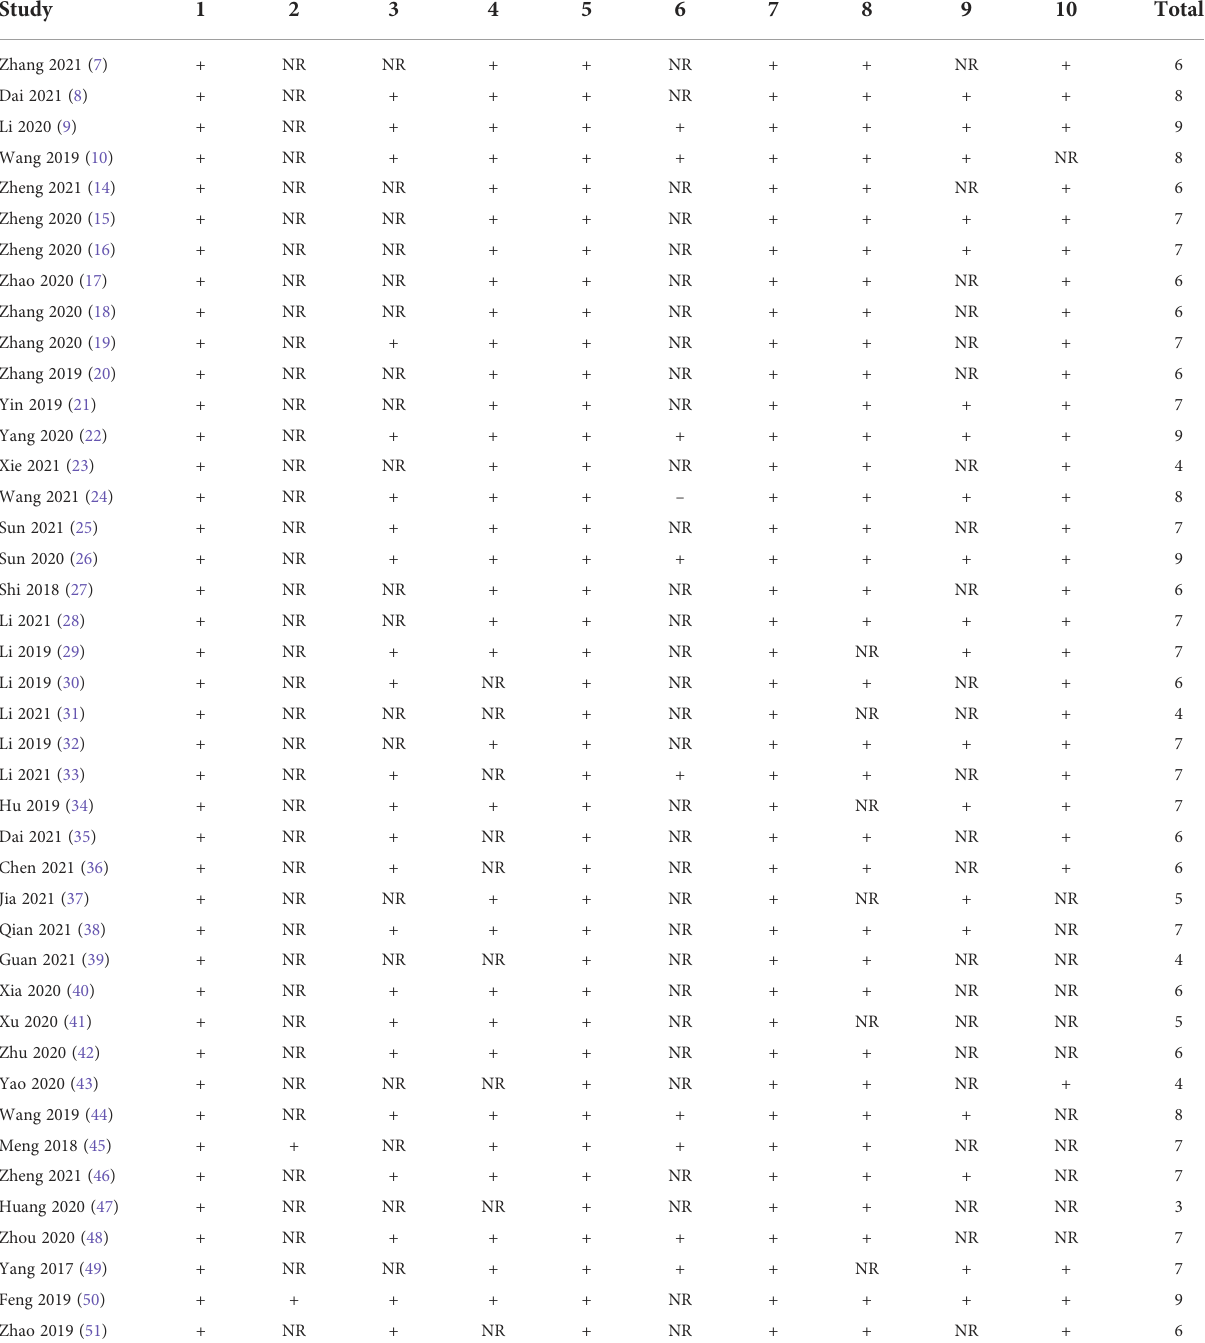
TABLE 4 Quality assessment of the experiments included in the